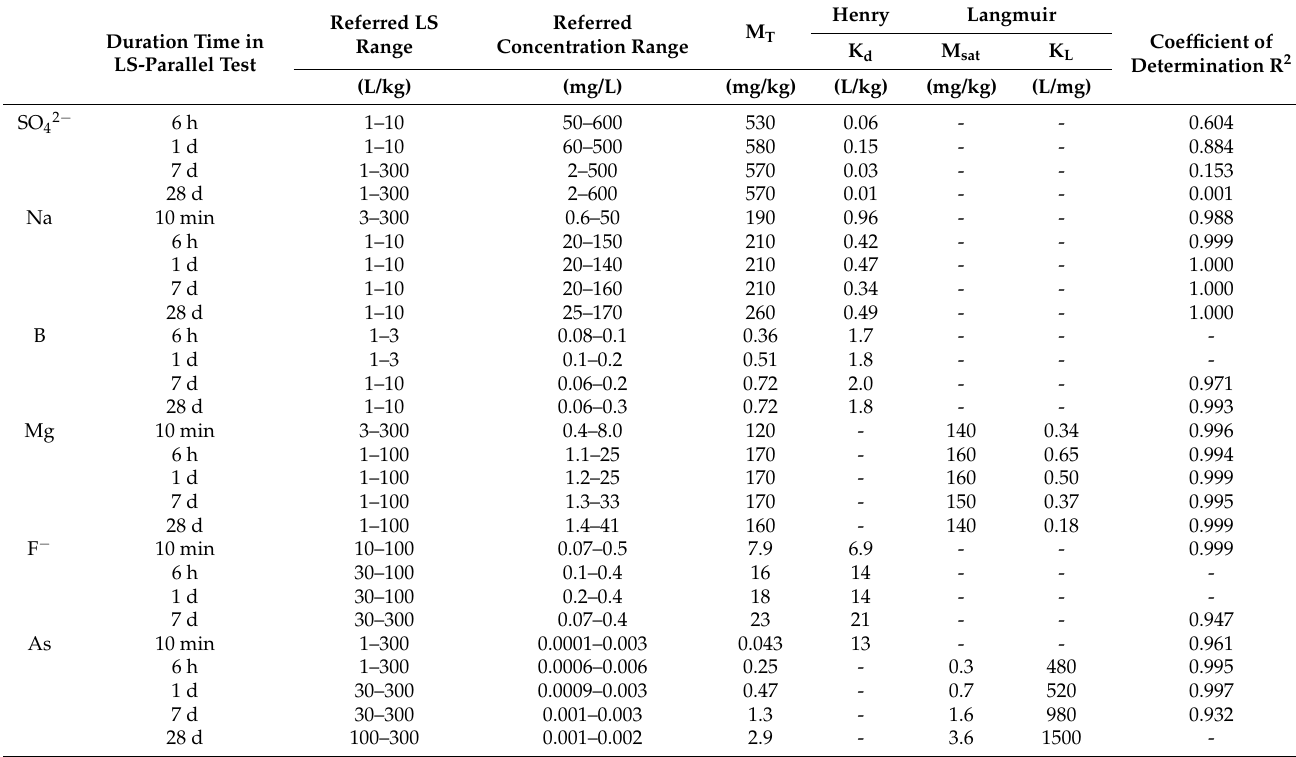
Table 3. Parameters obtained from LS-parallel